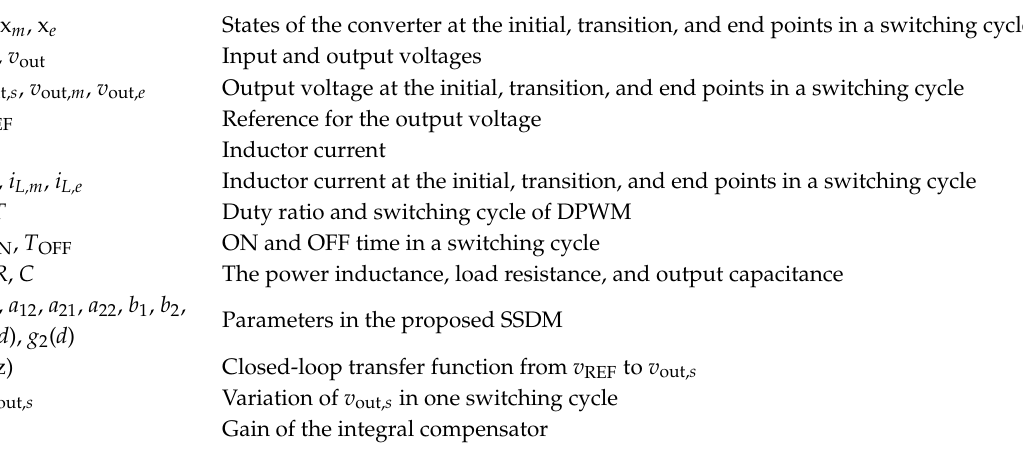
Figure 24. Output voltage transients under DPVP control when v REF steps from 5 to 6 V: ( a ) L a = 1.3 L and ( b ) L a = 1.6 L.